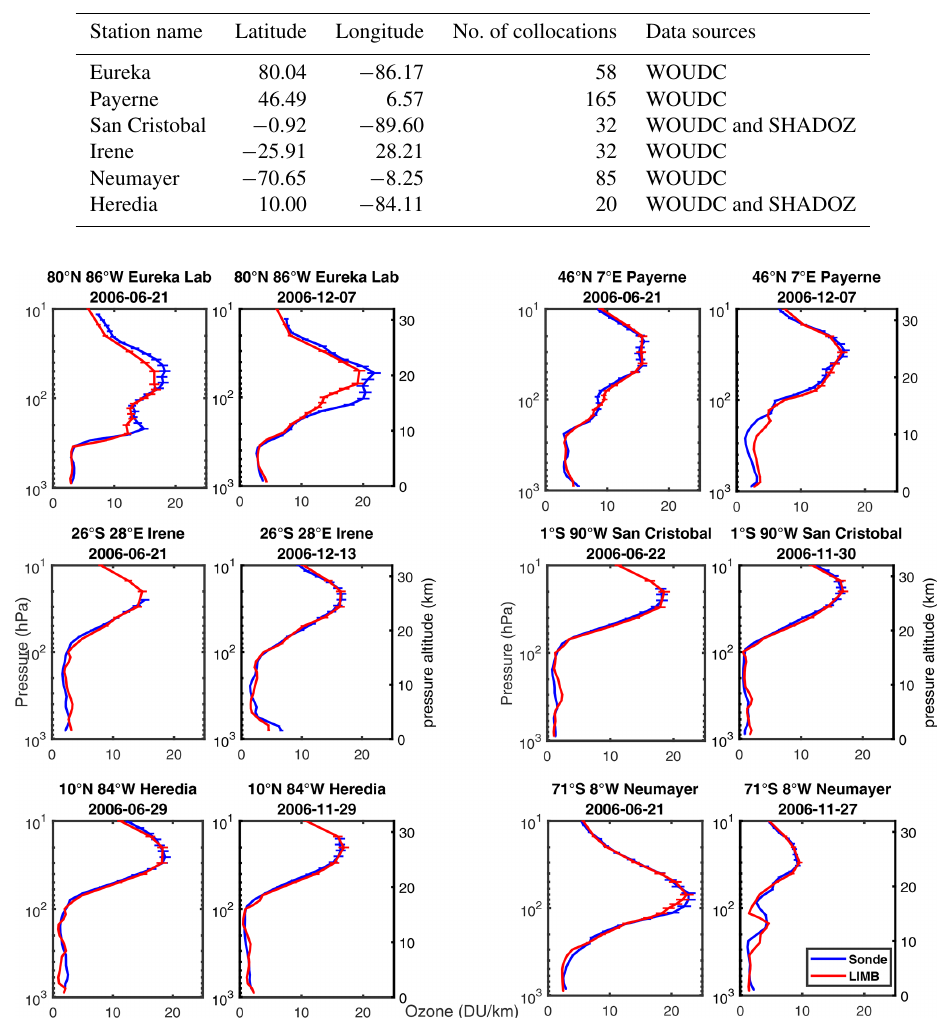
Figure 13. Several examples of ozonesonde data (blue lines with 1 σ uncertainties) with the collocated interpolated limb profiles (red lines with 1 σ uncertainties).